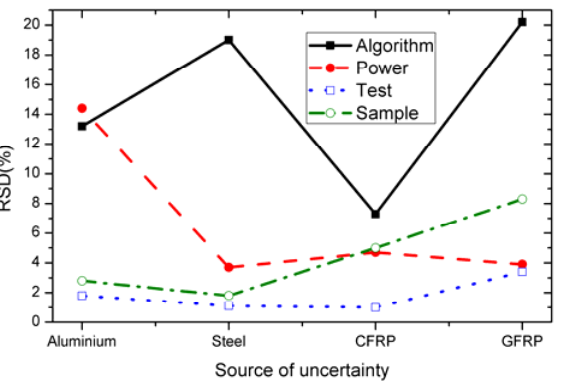
Figure 6. Uncertainty comparison caused by various sources for the considered four materials.